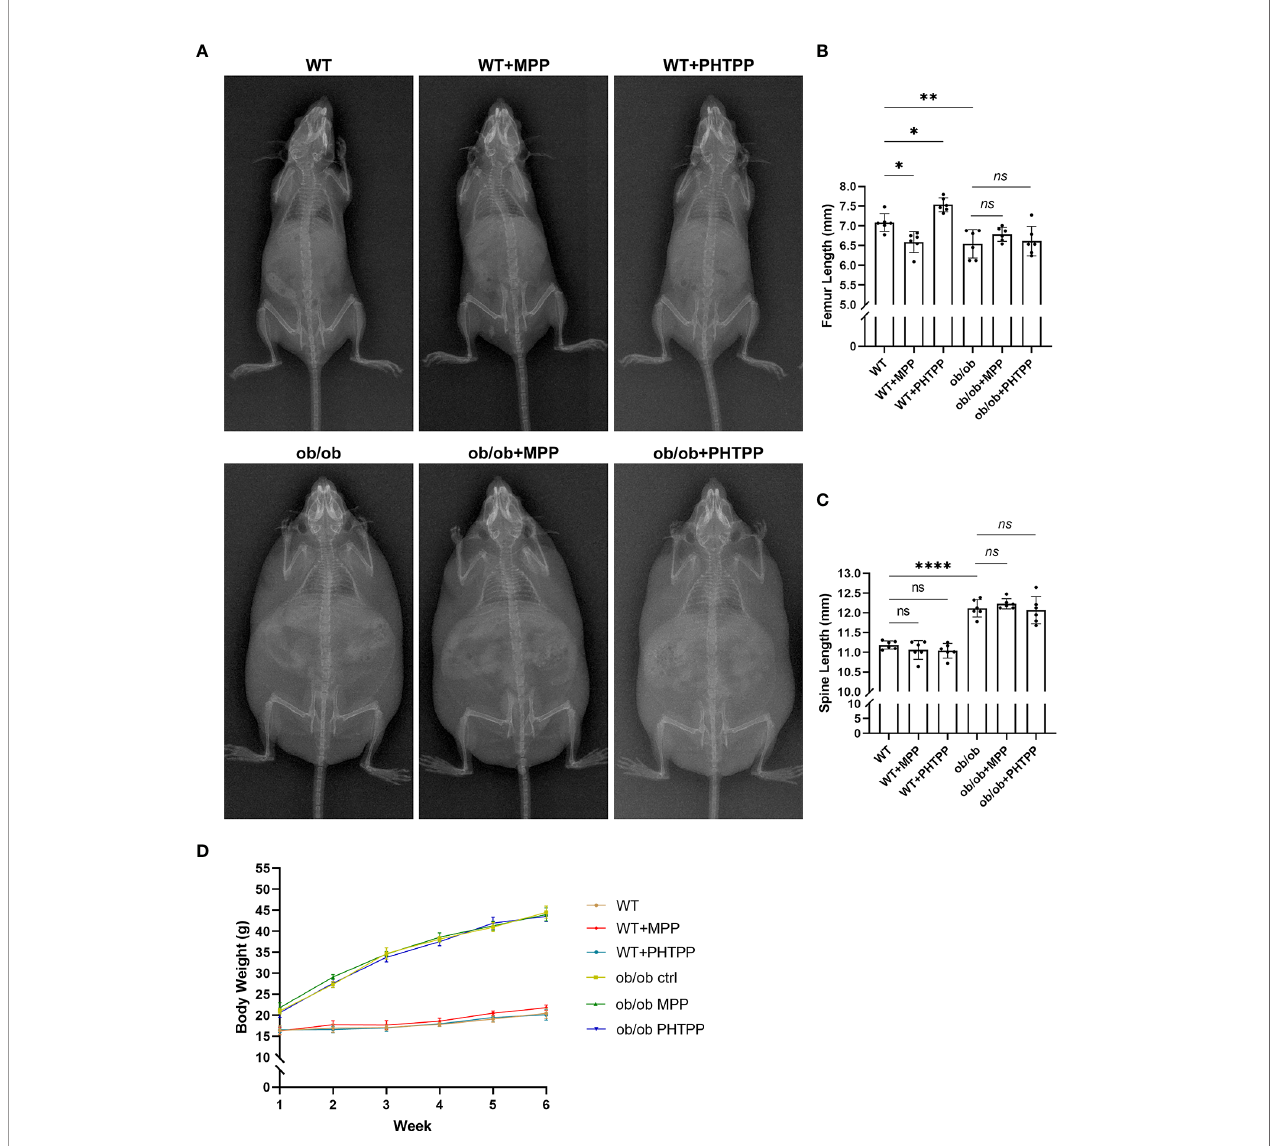
FIGURE 6 | Leptin de fi ciency disturbs the regulatory effects of estrogen receptor-selective antagonists on the body length. (A) X-ray plain fi lm of wild-type (WT) and ob/ ob mice. (B) Femur length. (C) Spine length. (D) Body weight. Values are means ± SD. n = 6, * p < 0.05, ** p < 0.01 and **** p < 0.0001; ns denotes not signi fi